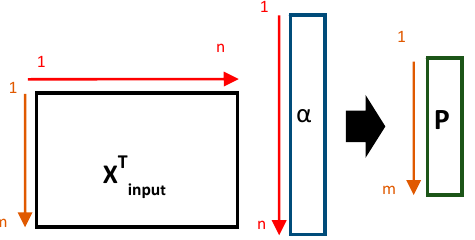
Figure 4. The P-vector is obtained by the inner product of X T and the α vector of the SVR model.